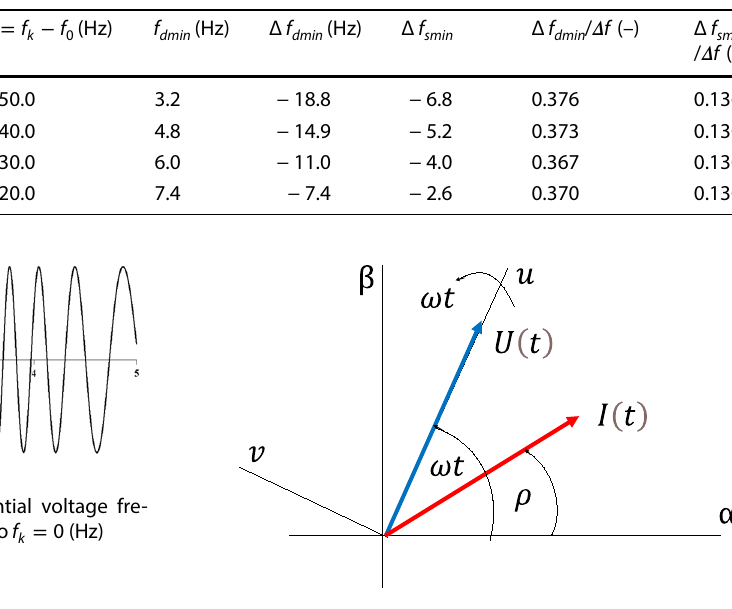
Fig. 18 Illustration of the voltage and current vectors on a complex plane in respect to the stationary frame